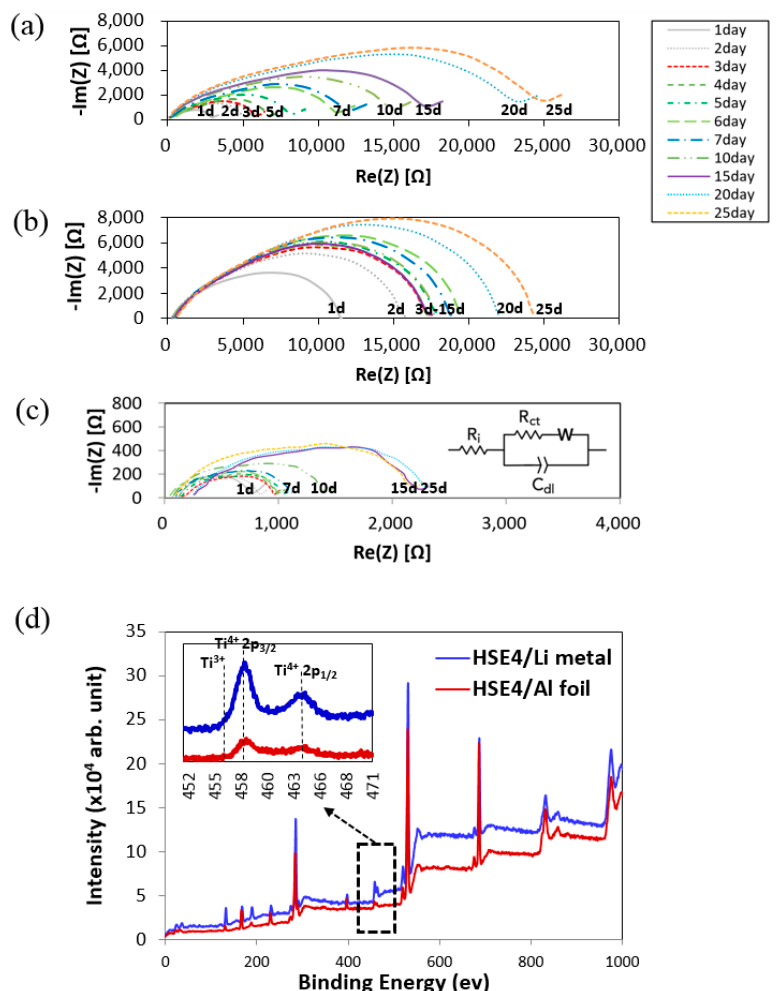
Figure 3. Impedance spectra of ( a ) Li/LATP/Li ( b ) Li/HSE-1/Li ( c ) Li/HSE-4/Li symmetric cells during 25 days ( d ) Ti2p 3/2 and Ti2p 1/2 photoelectron signals of Ti films (HSE-4) coated on Li metal and Al foil for 25 days.